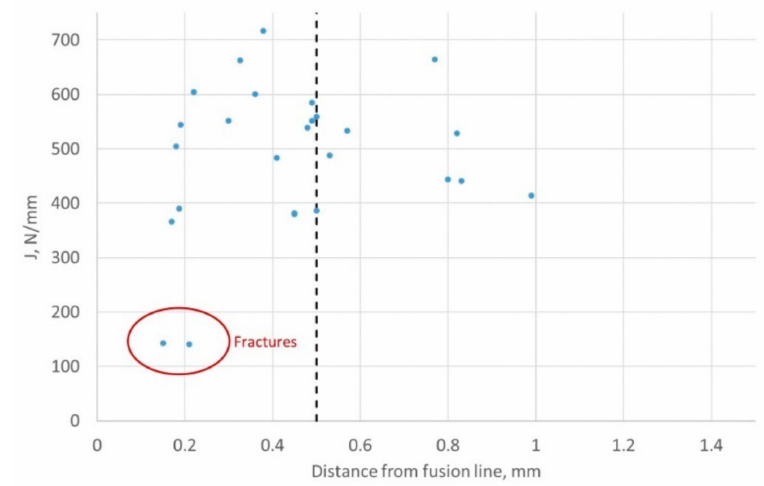
Figure 14. Results of quasi-static SENB specimens HAZ notched at the fusion line, plotted to show the fracture toughness, J against the shortest distance of the crack tip to the fusion line. The results to the left of the dotted line are ‘valid’. Table 4. Results of fusion line fracture toughness tests carried out at − 10 ◦ C, including the distances of the crack tip from the fusion line, both in the crack plane (s1) and parallel to the crack if measured (s2). Also indicated is whether the notch tip was located on the weld metal side of the fusion line or the HAZ side of the fusion